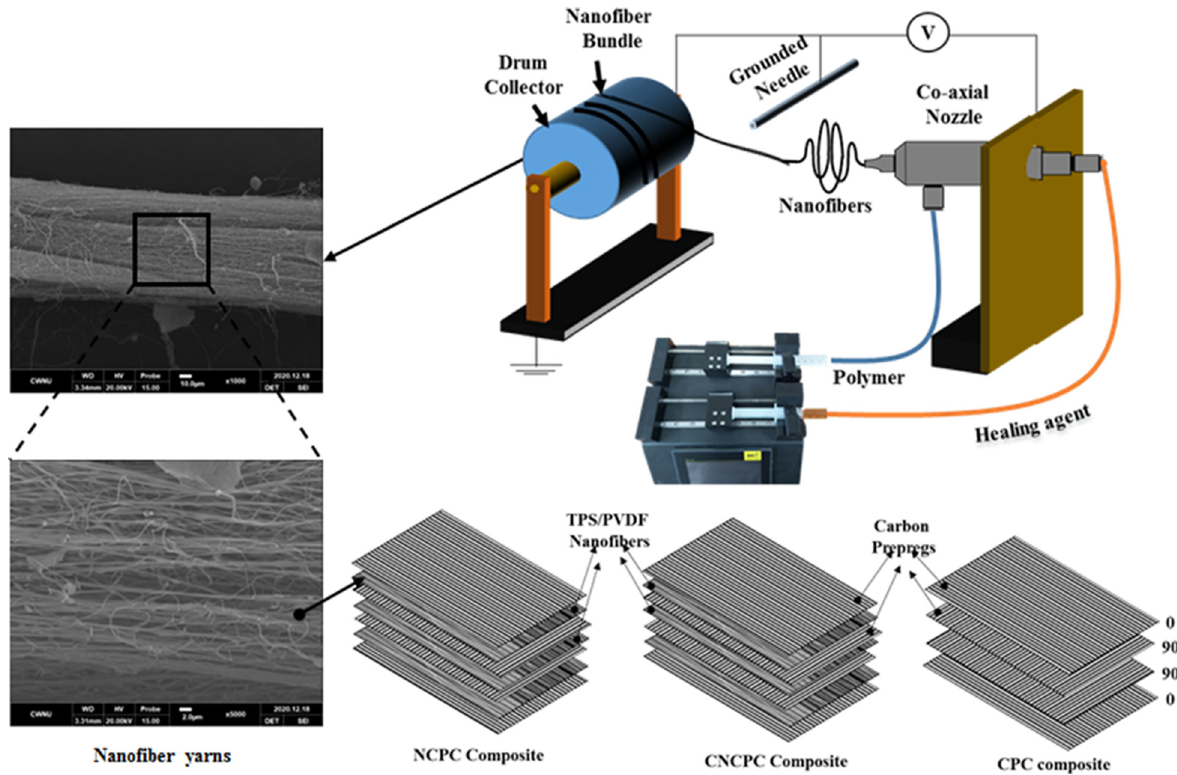
Figure 1: Schematic representation of the synthesis of nano fi bers and stocking sequence of carbon/epoxy prepregs and nano fi bers for the manufacturing of the self - healing